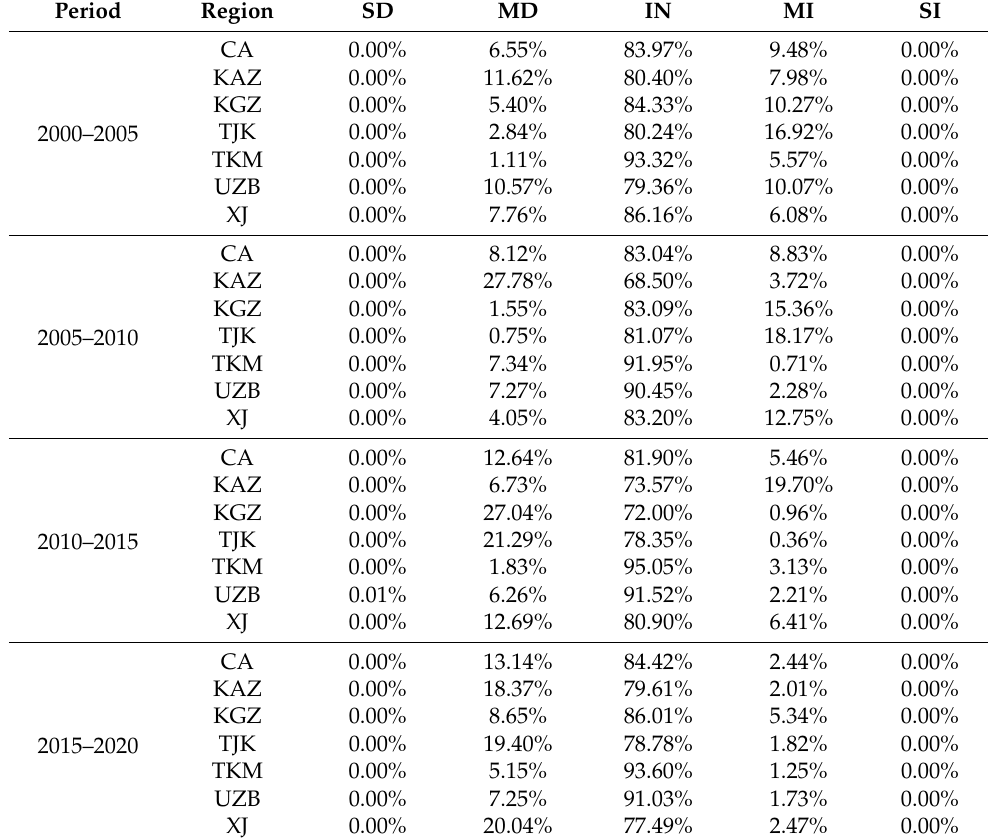
Table 3. Spatial distribution of changes in the EEQ of CA and its six regions in various periods. Period Region